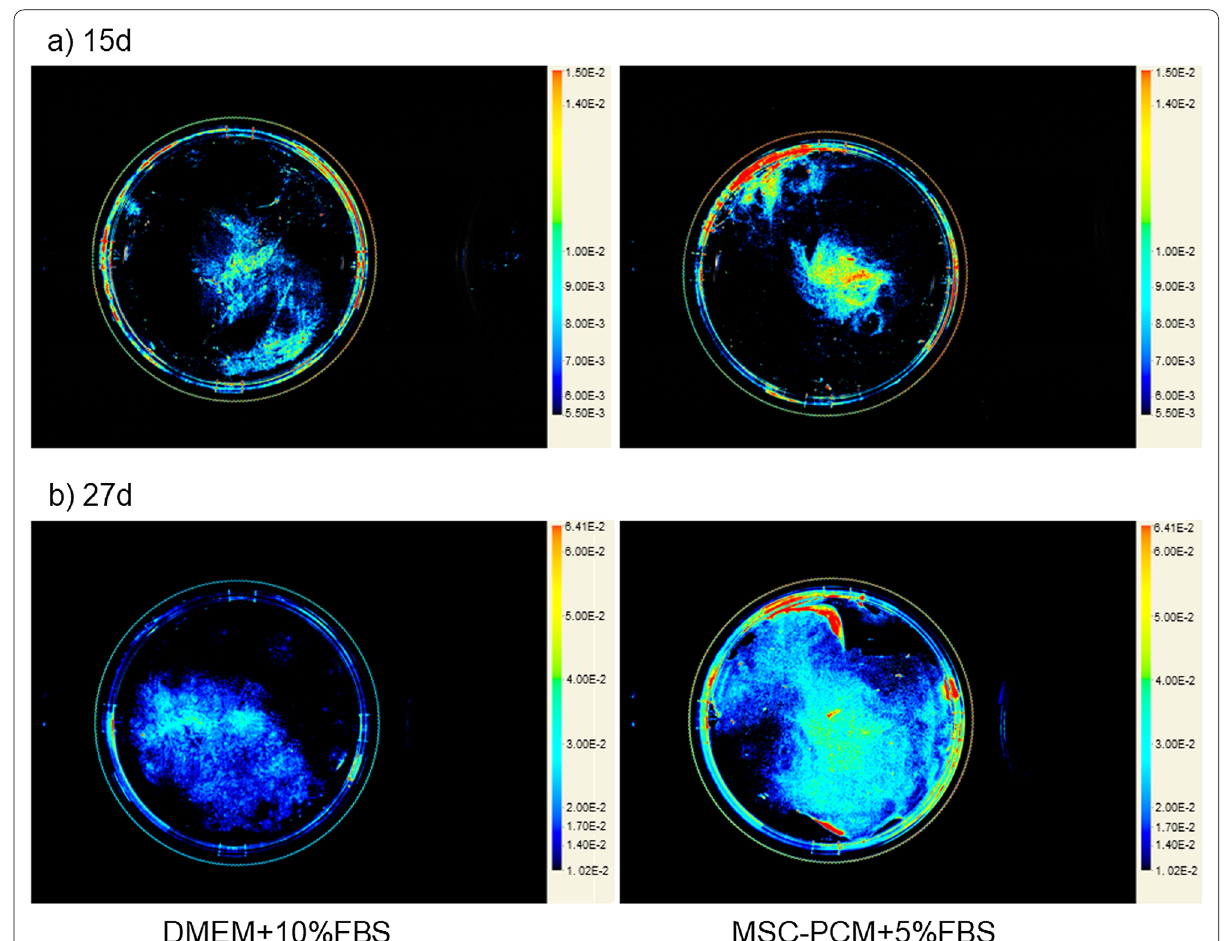
Fig. 7 Optical near-infrared imaging of the thickness, that is, three-dimensional growth of living periosteal sheets using CellVue ®